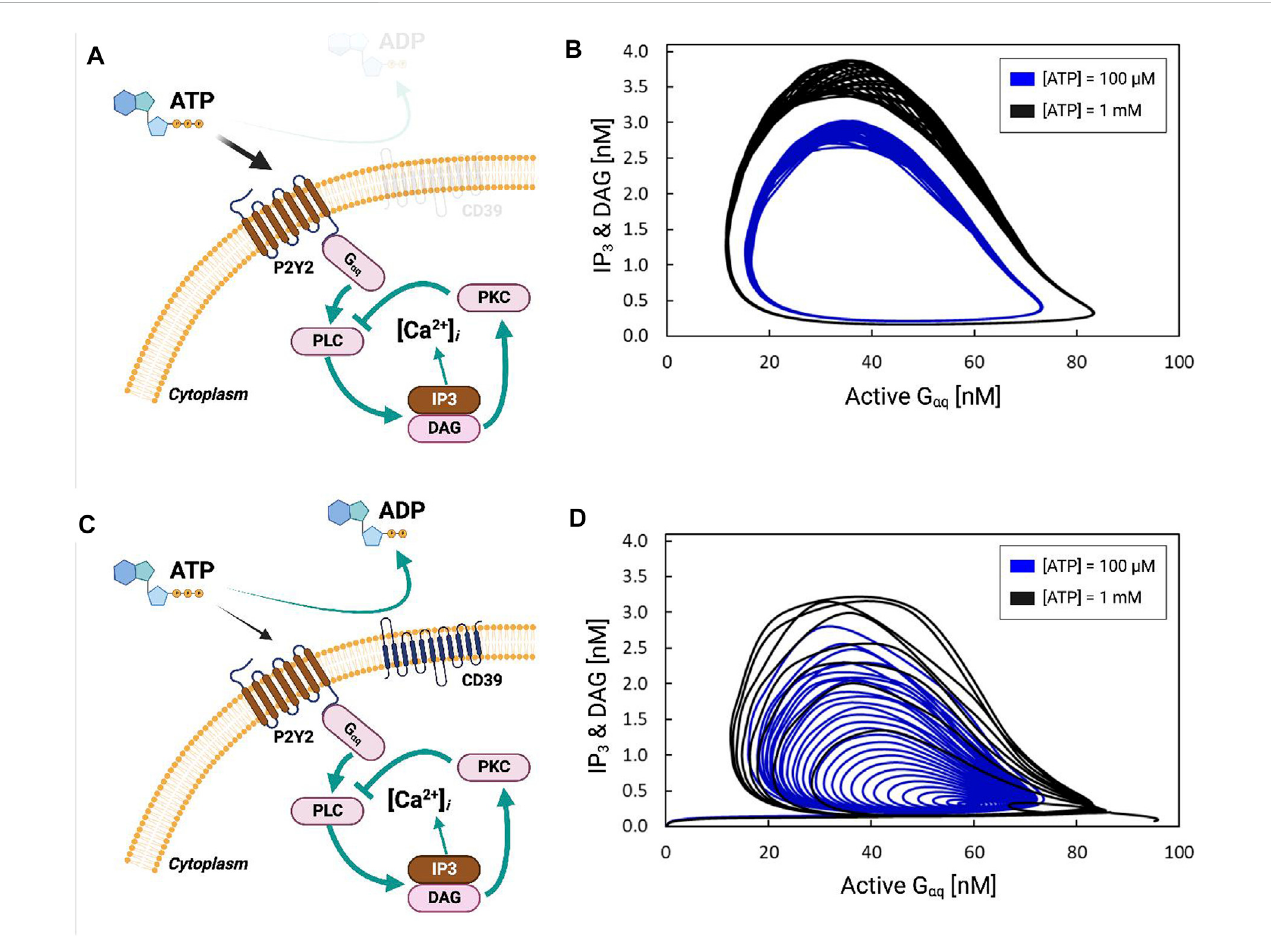
FIGURE 3 (A) Schematicof P 2 Y 2-dependentactivationof IP 3 production viaG α q . (B) IP 3 andDAGconcentration[nM]asafunctionofactivated G α q [nM]inresponse to 100 µM (black) and 1 mM (blue) ATP. The cyclic nature re fl ects that the concentrations are oscillatory. (C,D) are equivalent to (A,B) , except that the simulation includes the hydrolysis of ATP by the ectonucleotidase